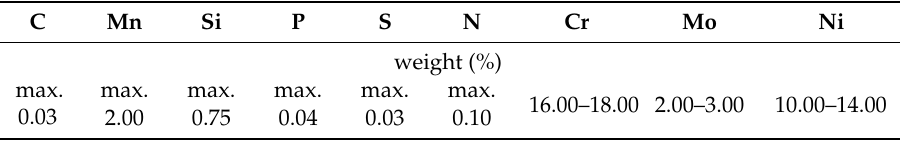
Table 1. Nominal chemical composition of 316L steel.